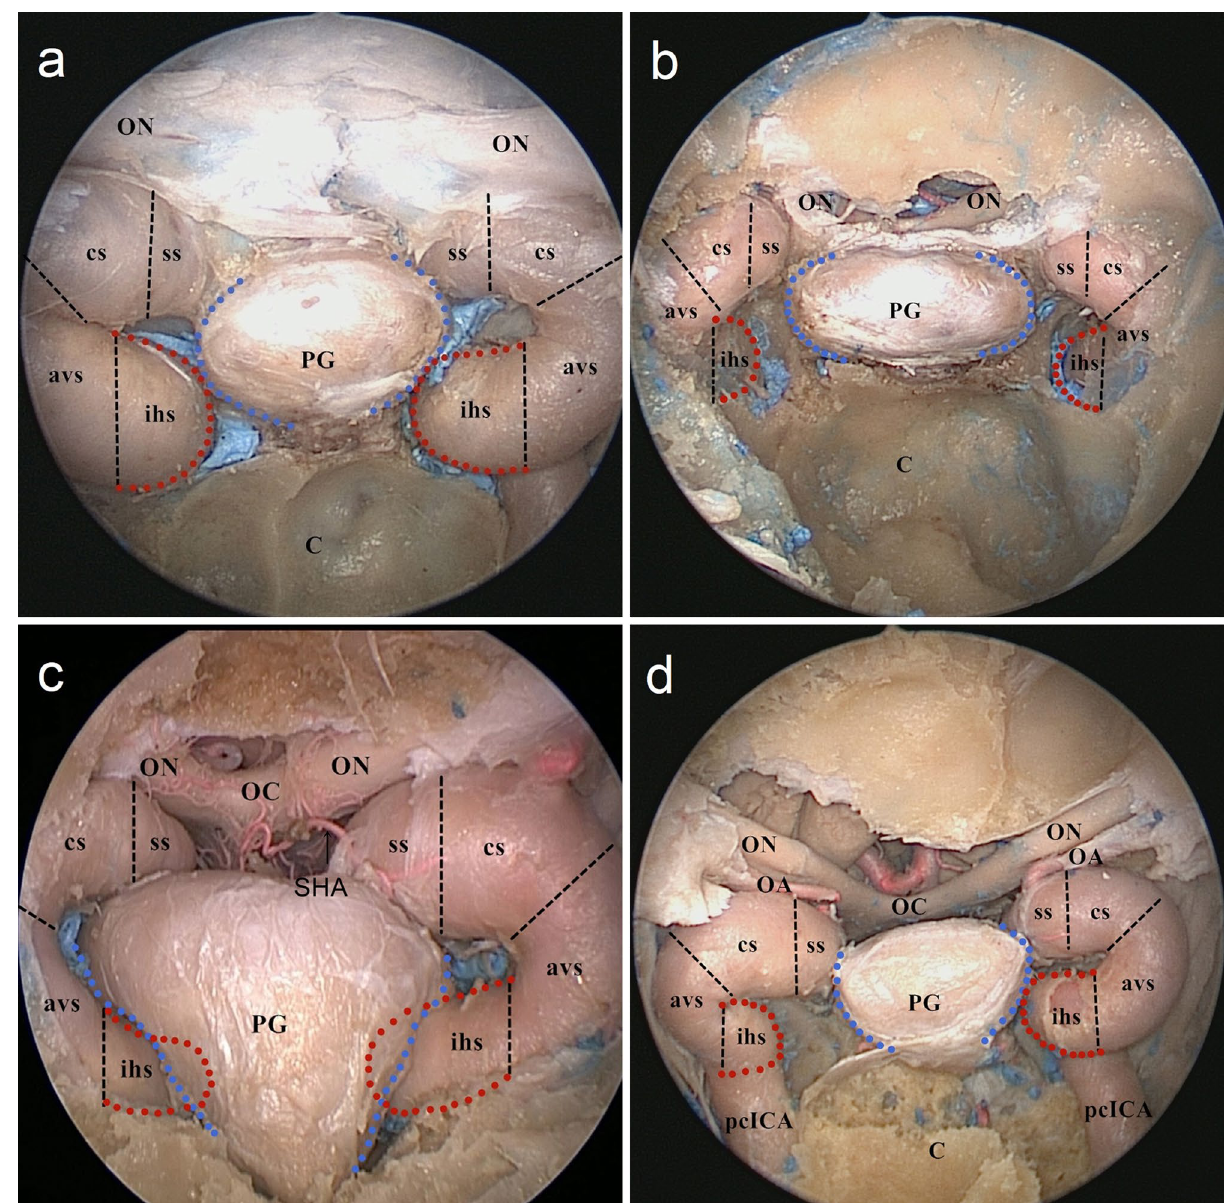
Figure 5. The relationship between the lateral surface of the pituitary gland (PG) and the inferior horizontal segments of the internal carotid artery (ihsICA). ( a ) the bilateral ihsICAs (the red dotted line) are attached contacts with the lateral surface of the PG (the blue dotted line) corresponding to contiguity. ( b ) the bilateral ihsICAs are separated from the lateral surface of the PG corresponding of separation. ( c ) the bilateral ihsICAs are extended to the lateral surface of the PG corresponding to indentation. ( d ) the right ihsICA is separated from the lateral surface of the PG whereas the left one is close contact. ON optic nerve, OC optic chiasm, OA ophthalmic artery, SHA superior hypophyseal artery, PG pituitary gland, C clivus, pcICA paraclival segment of the ICA, his inferior horizontal segment of the ICA, avs anterior vertical segment of the ICA, cs clinoidal segment of the ICA, ss subarachnoid segment of the of the PG was 5.70 ± 1.15 mm; the mean distance B; from the medial border of the anterior vertical segment of cavernous ICA to the mid-line of the PG was 10.37 ± 1.79 mm (Fig. 4). There were no significant differences between the left and the right sides. All measurements are displayed in Table 1. The relationship between the lateral surface of the pituitary gland (PG) and the inferior horizontal segment of the ICA (ihsICA) was stratified into three types: contiguity (40%, 12/30), separation (26.7%, 8/30), and indenta- tion (33.3%, 10/30). Notably, the relationship between the lateral surface of the PG and bilateral ihsICAs were not always consistent, (20%, 3/15), as shown in Table 2 and Fig. 5. The medial wall of the CS was removed. The anteroinferior compartment which was superior to the bottom of CS and inferior to the proximal dural ring of the CS venous space resembled a boat’s bow. It was anteriorly limited